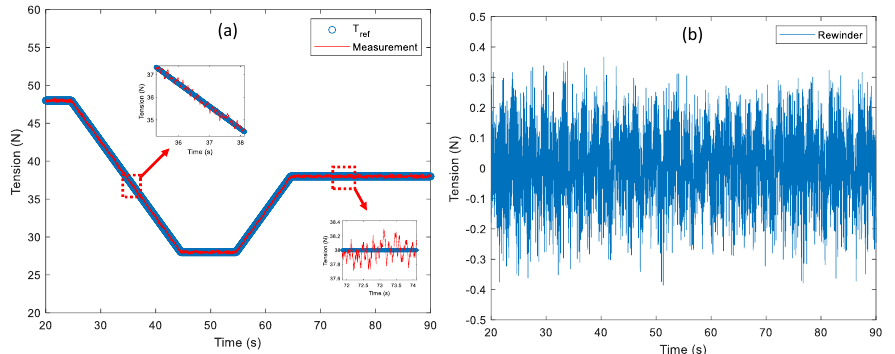
Figure 11. The control performance of the changes in the reference tension is validated at 0.1 m/s of the web speed: ( a ) comparison between the reference tension and measurement and ( b ) tension tracking